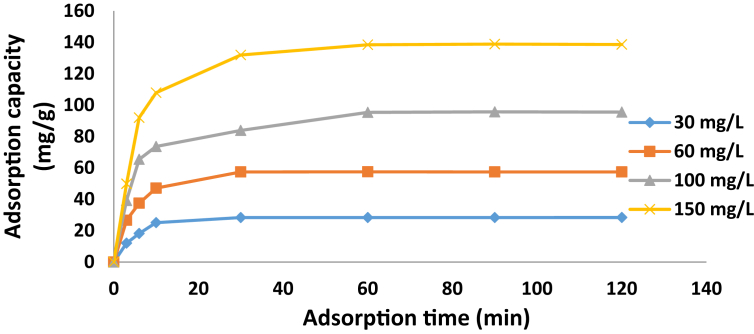
Adsorption time effect on the adsorption capacity of Pb2+ onto acid activated Aloji clay (temperature = 30 °C, rpm = 140, V = 100 ml, W = 0.10 g, pH 7).